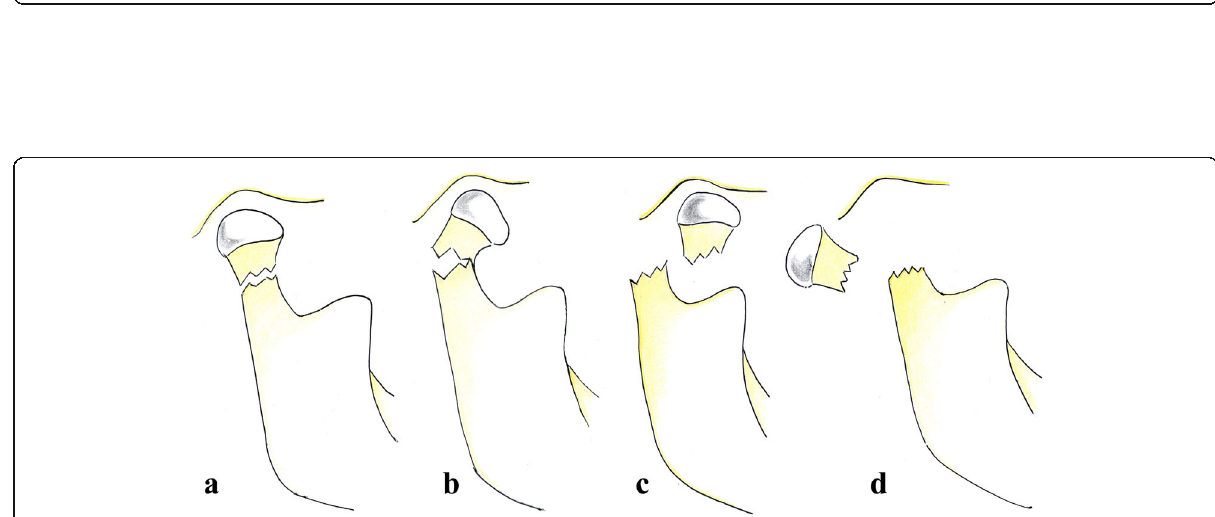
Fig. 13 Picture depicting mandibular condyle fractures in according to the classification given by MacLennan et al. a No deviation. The bone fragments are in line and close to each other. The articular relation between the condylar head and glenoid fossa is maintained. b Deviation. A contact between the two bone fragments is observed but they are not in line. The articular relation between the condylar head and glenoid fossa is maintained. c Displacement. The condylar head remains within the glenoid fossa but there is no contact between the two bone fragments. d Dislocation. The articular relation between the condylar head and glenoid fossa is